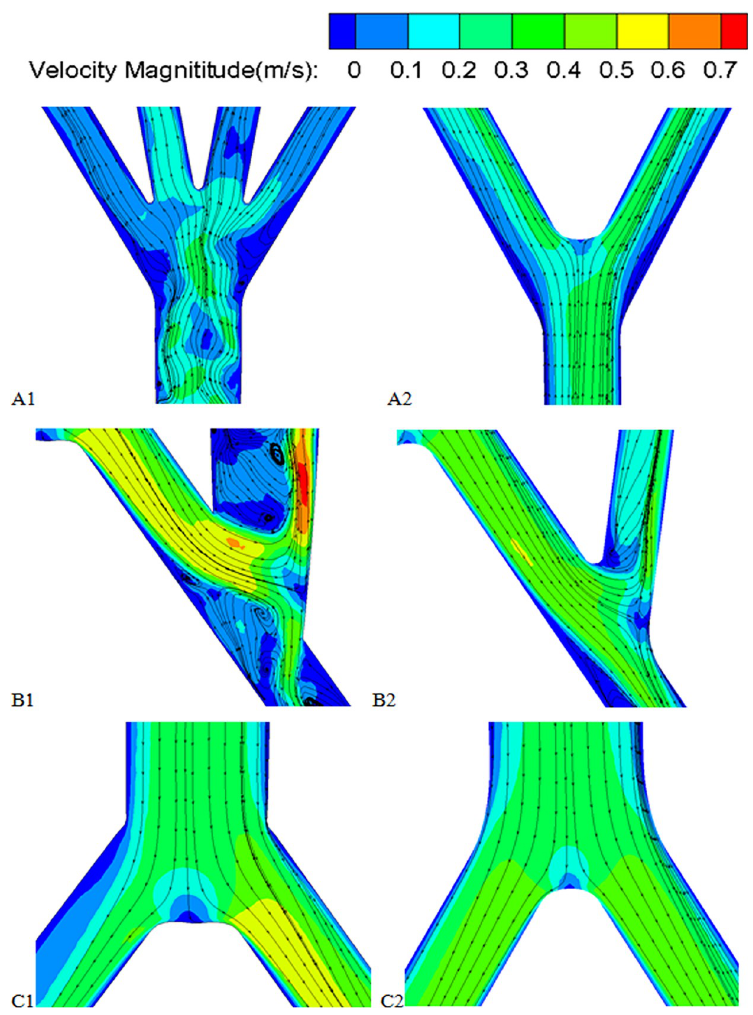
Fig 7. The streamlines superimposed the contour maps of velocity magnitude in the symmetry planes. A1, A2) the graft bifurcation; B1,B2) the aorta bifurcation; C1,C2) the anastomosis region. A1,B1,C1 represent the local regions of the RVR with unilateral quar-furcated graft; A2,B2,C2 represent the local regions of the RVR with bilateral bi-furcated grafts. Fig 7 shows the streamlines superimposed on the contour maps of the velocity magnitude in the planes of symmetry. For both cases, when fluid was flowing from the host artery to the graft, the sudden geometric change shifted the fluid towards the outer wall of the graft under the action of circumferential forces, and flow recirculation zones appeared near the inner wall, the toe region and host artery bed. It is obvious that compared with the bi-furcated graft case, the quar-furcated graft had a more disturbed and chaotic flow pattern, not only in the anasto- mosis region, but at the graft bifurcation. To have a better view of the effect of the graft type on the hemodynamic parameters, 8 slices of the configurations, as shown in Fig 8, were chosen for the calculation of the area-averaged WSS and pressure drop. For both cases, the WSS experienced a sharp increase from S3 section to S4 section at the artery-graft anastomosis. A unilateral quar-furcated graft gave rise to a more fluctuating WSS, and the averaged WSS of the S4 section was more than 50 dyne/cm 2 ,